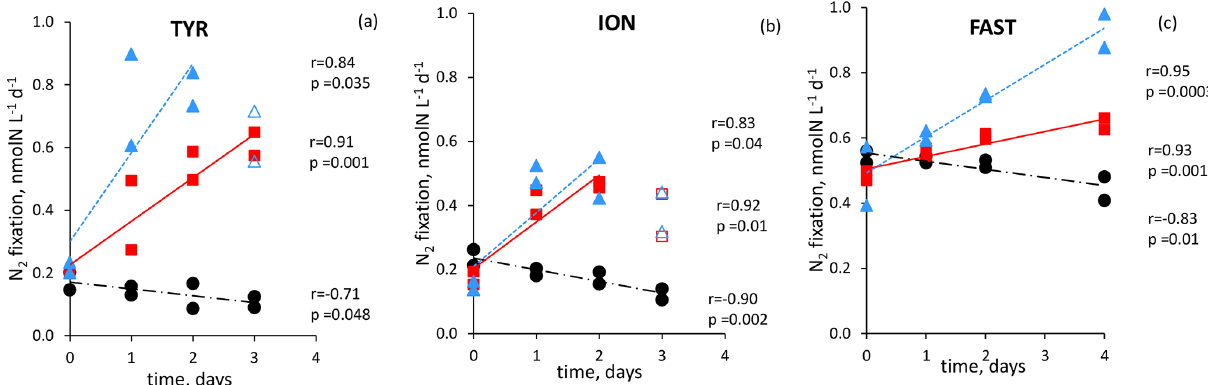
Figure 6. N 2 fixation rate in nmolNL − 1 d − 1 during the dust seeding experiments performed at the stations TYR (a) , ION (b) and FAST (c) in the replicated controls (black dot), dust treatments under present climate conditions (red square, D treatment) and dust treatments under future climate conditions (blue triangle, G treatments). Open symbols were not included in the linear regression